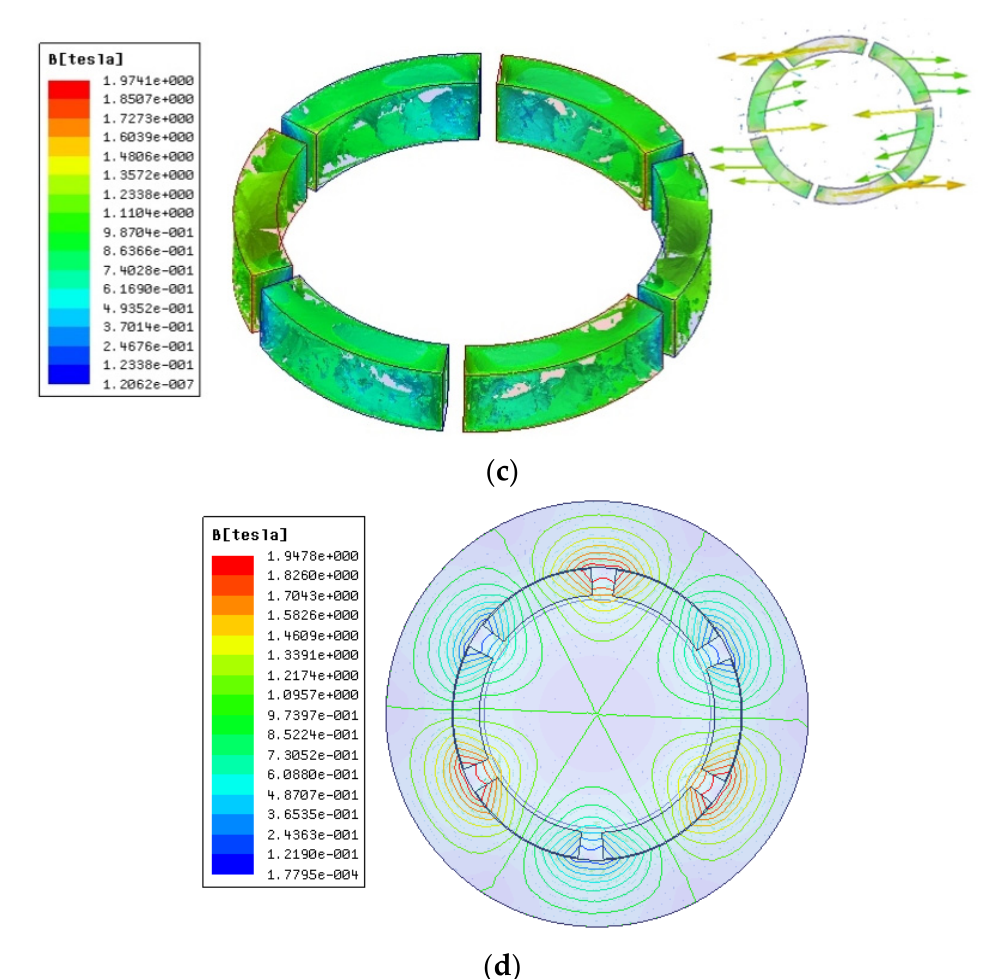
Figure 5. Magnetization modes: ( a ) radial magnetic dense cloud diagram; ( b ) radial magnetic line distribution; ( c ) parallel magnetizing dense cloud diagram; and ( d ) parallel magnetizing force line.